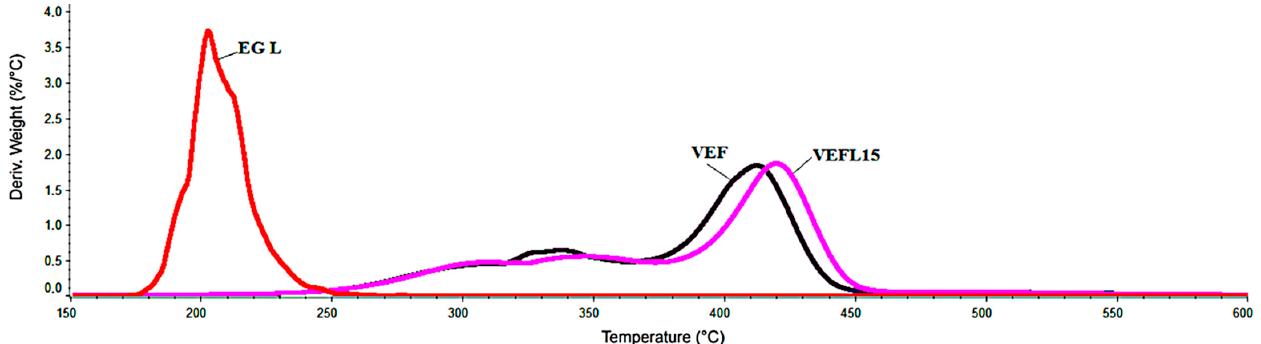
Figure 6. Comparison of DTG curves: EG L, VEF, and VEFL15.